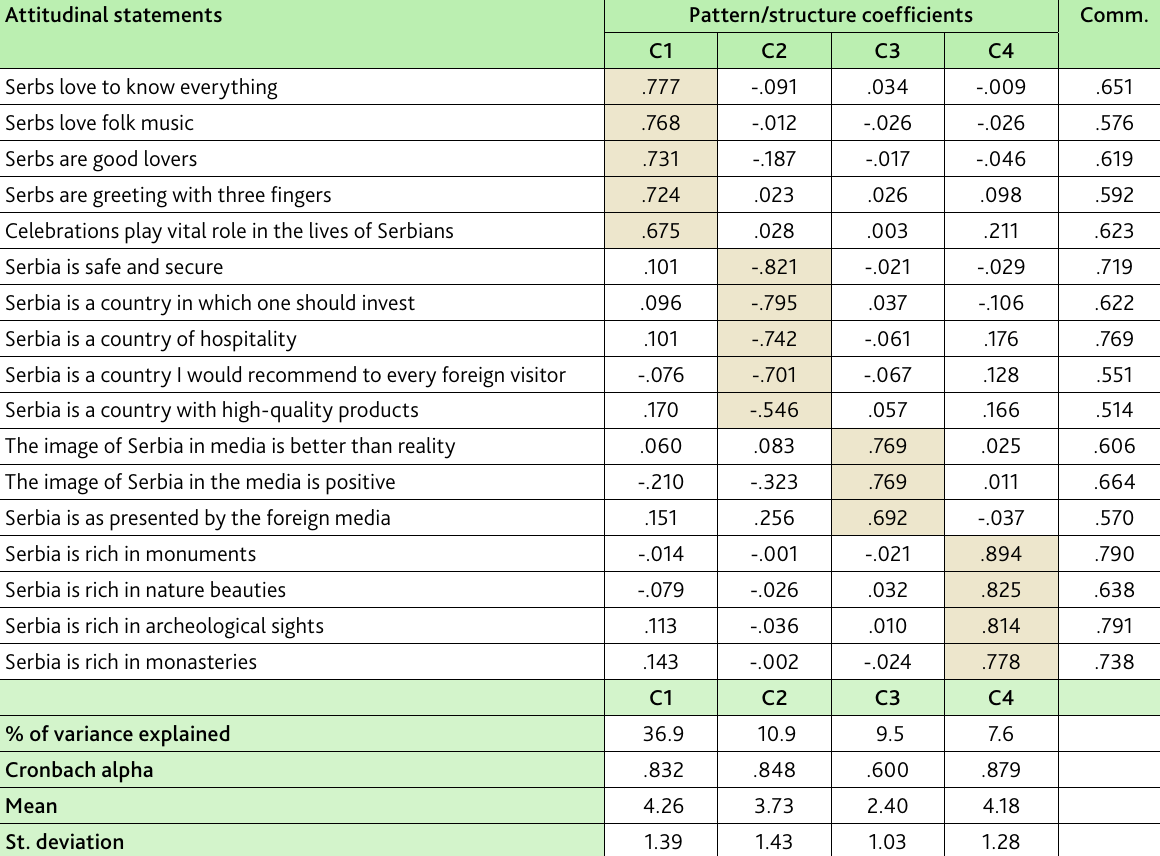
Table 2. Serbia brand identity Italian perception – rotated component matrix for PCA with Oblimin rotation for 4 factors